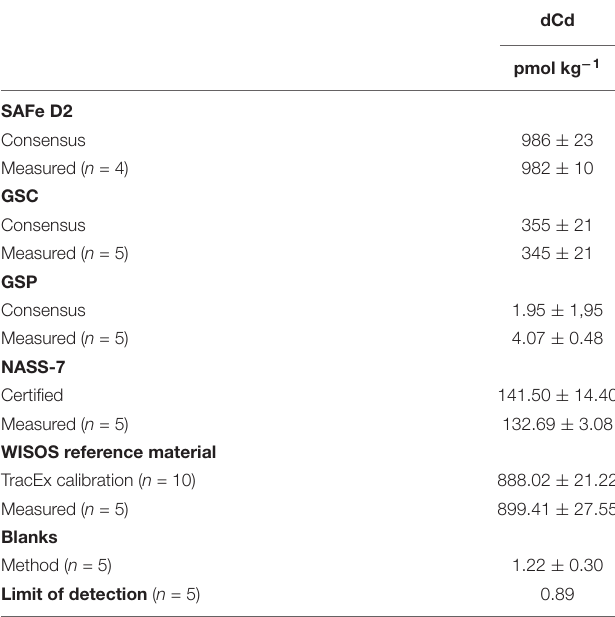
TABLE 1 | Results for dCd from the ICP-MS analysis of GEOTRACES SAFE D2, GSC, and GSP seawater reference materials (https://www.geotraces.org/standards-and-reference-materials/), NASS-7 certified seawater reference material and our own WISOS internal reference seawater are compared with respective consensus